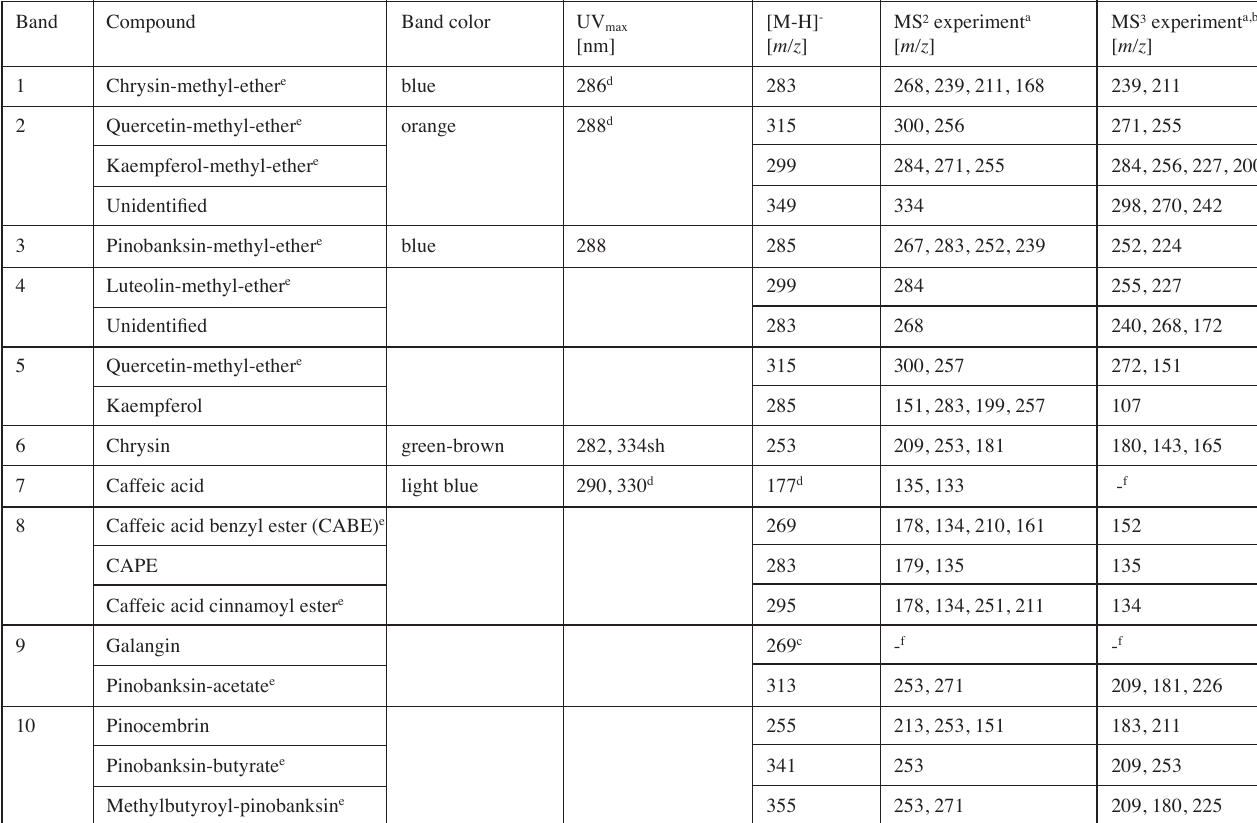
Tab. 3: TLC-MS and UV spectroscopic data obtained from the analysis of O-type propolis (see Fig.